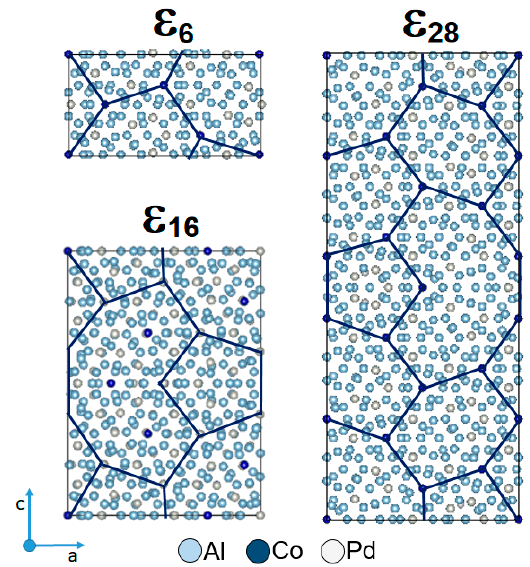
Figure 5. Two-dimensional projection of the crystal structure of ε 6 , ε 16 , and ε 28 . The phason tiling is denoted by dark-blue lines. For the color interpretation of this figure, the reader is referred to the web version of this